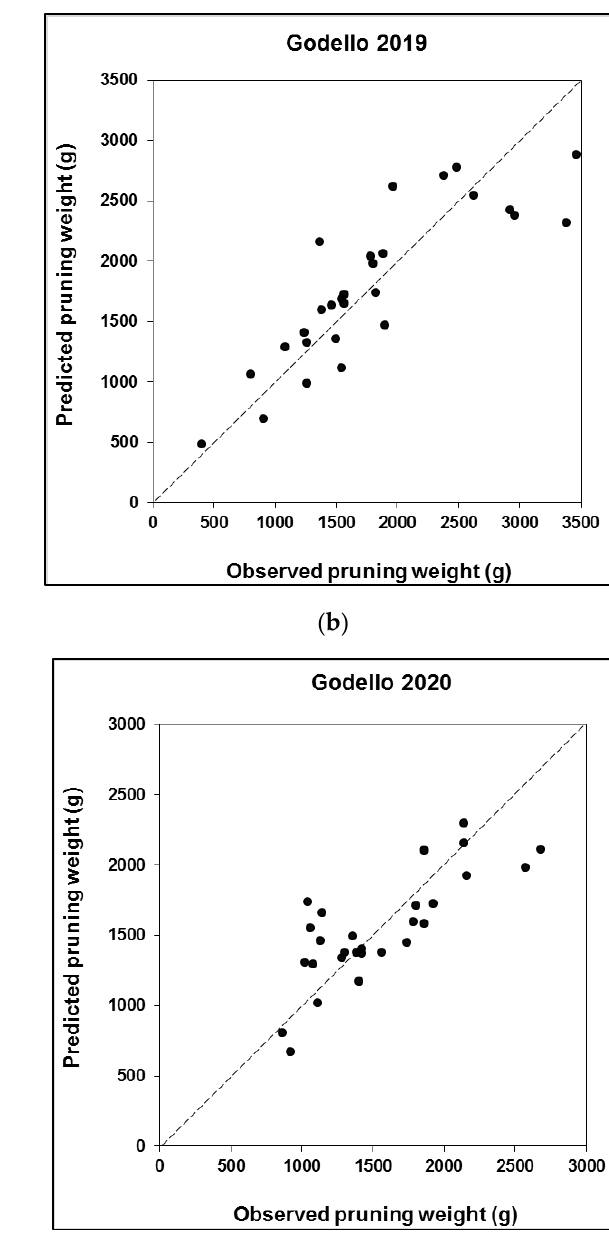
Table 4. Results of leave-one-out cross validation for predicted pruning weight.